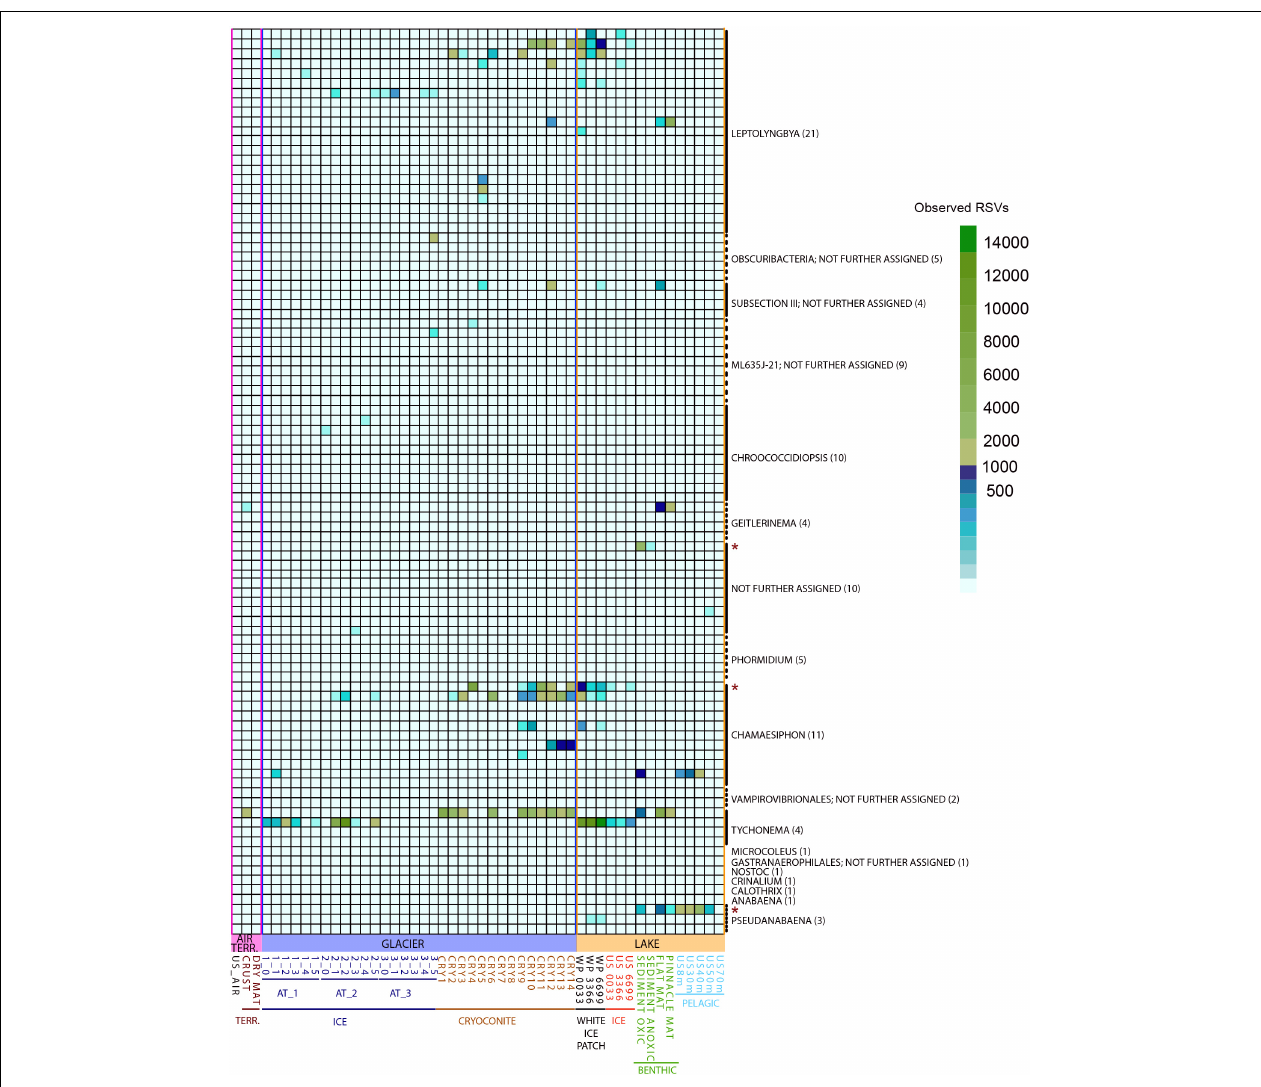
FIGURE 8 | Observed RSVs belonging to the phylum Cyanobacteria (affiliated to genus level, numbers of RSVs in brackets) in individual samples, depicted as heatmap. Significantly different abundant RSVs are marked with a red